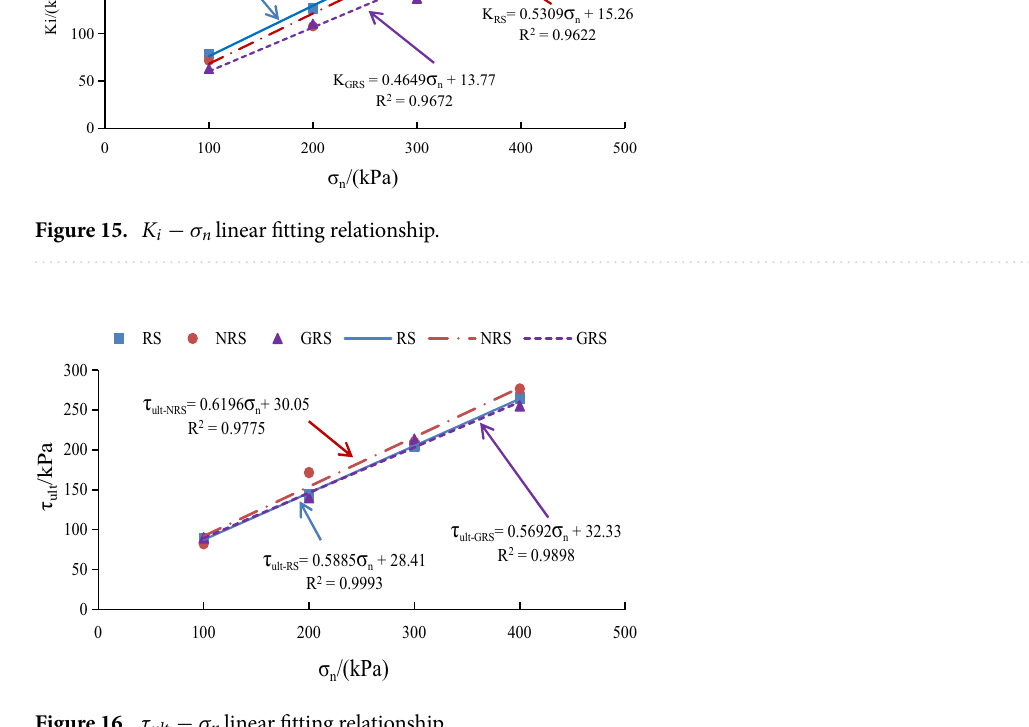
Figure 16. τ ult − σ n linear fitting